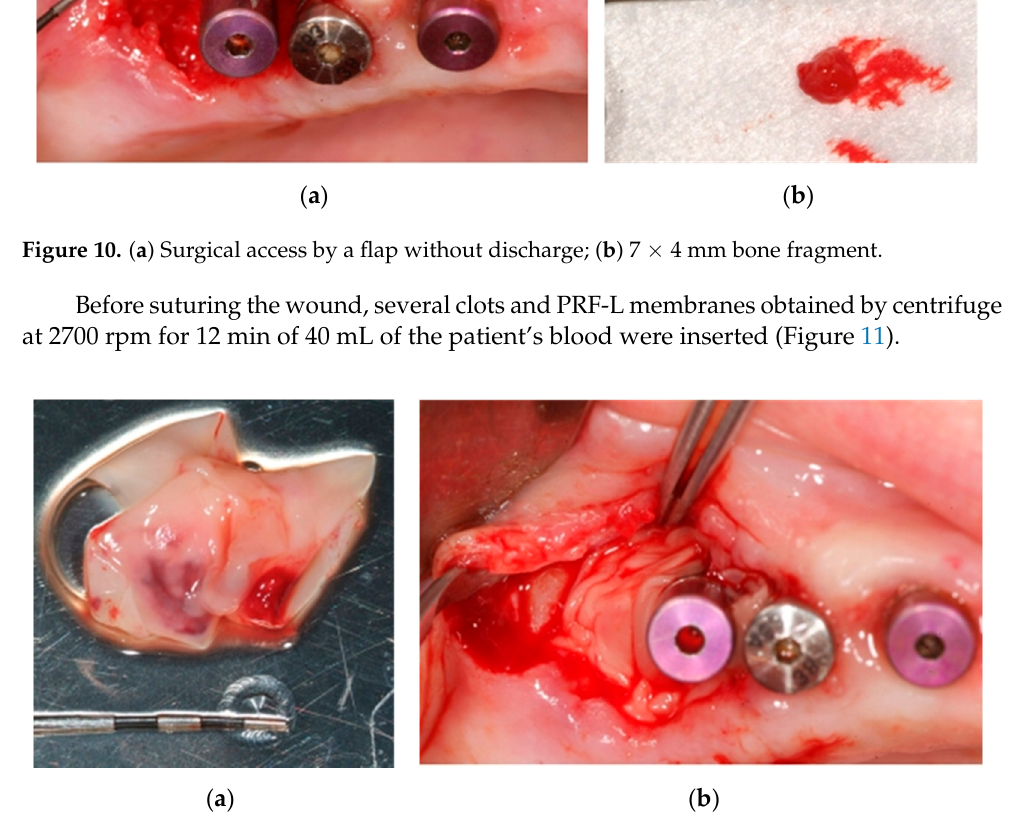
Figure 11. ( a ) PRF-L membranes; ( b ) Adaptation of PRF-L in bone defect and affected implant. The wound was sutured with non-resorbable polytetrafluoroethylene 6/0 monofilament (Seramon®, SERAG Wiessner Iberia, Madrid, Spain) and an intraoral control X-ray taken (Figure 12). The same antibiotic therapy and 0.12% chlorhexidine rinses were maintained for a week.